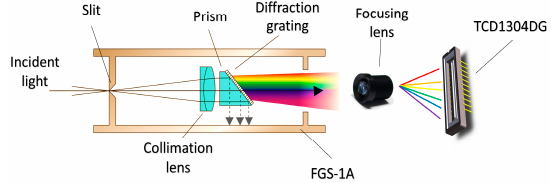
Figure 3. Spectroscopic module of the portable smart spectrometer.